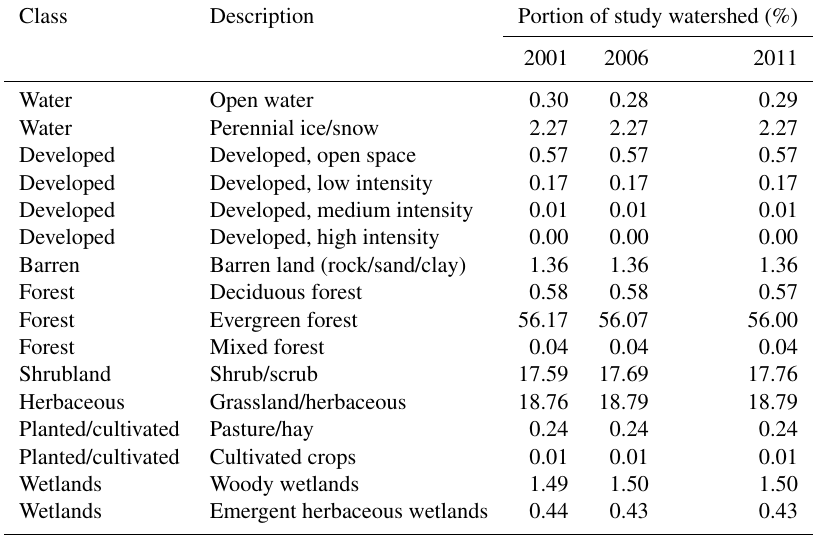
Table A1. Comprehensive distribution of LULC in study watershed based on NLCD 2001, 2006, and 2011.